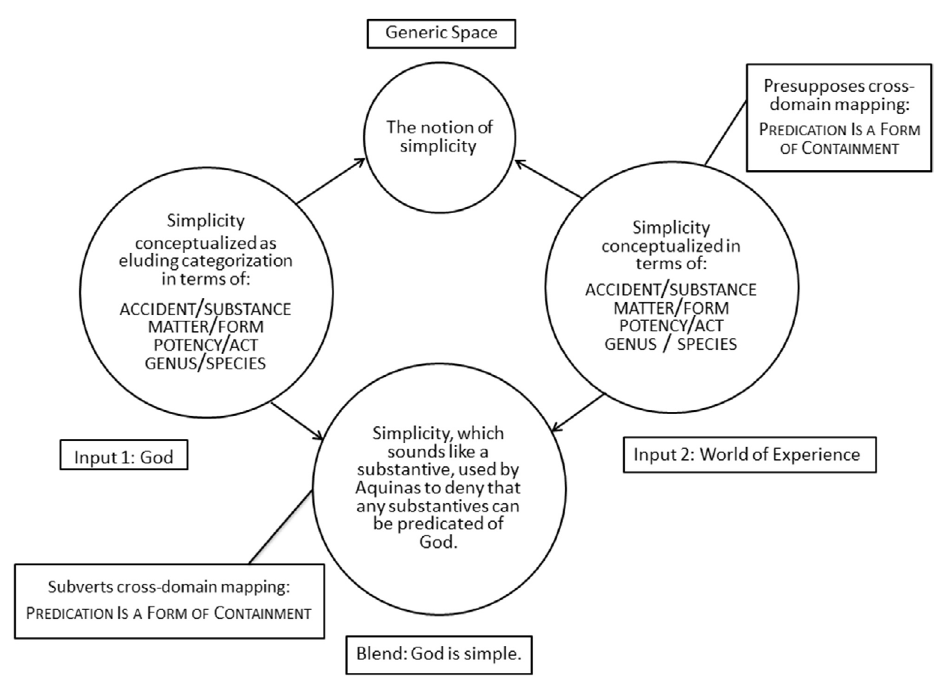
Figure 4. Cognitive mapping of Aquinas’s blend: god is simple